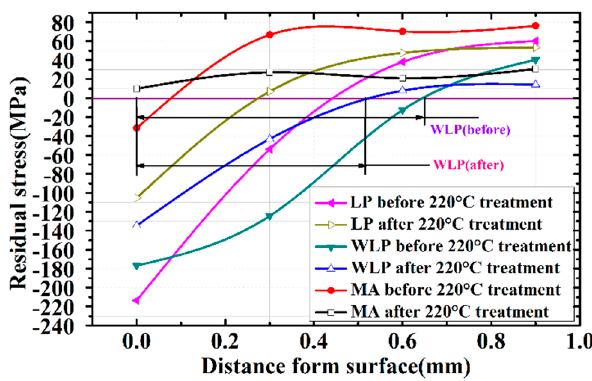
Figure 9. Residual stress distribution in depth of samples before and after aging.